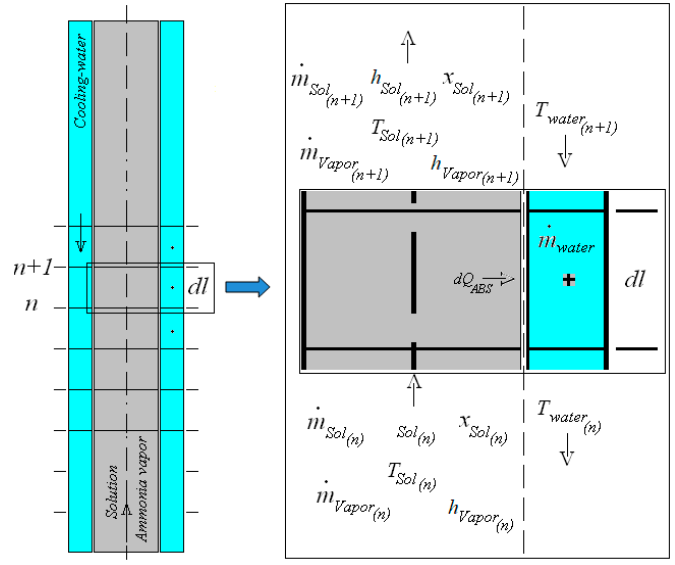
Figure 3. Geometric discretization of the bubble absorber.